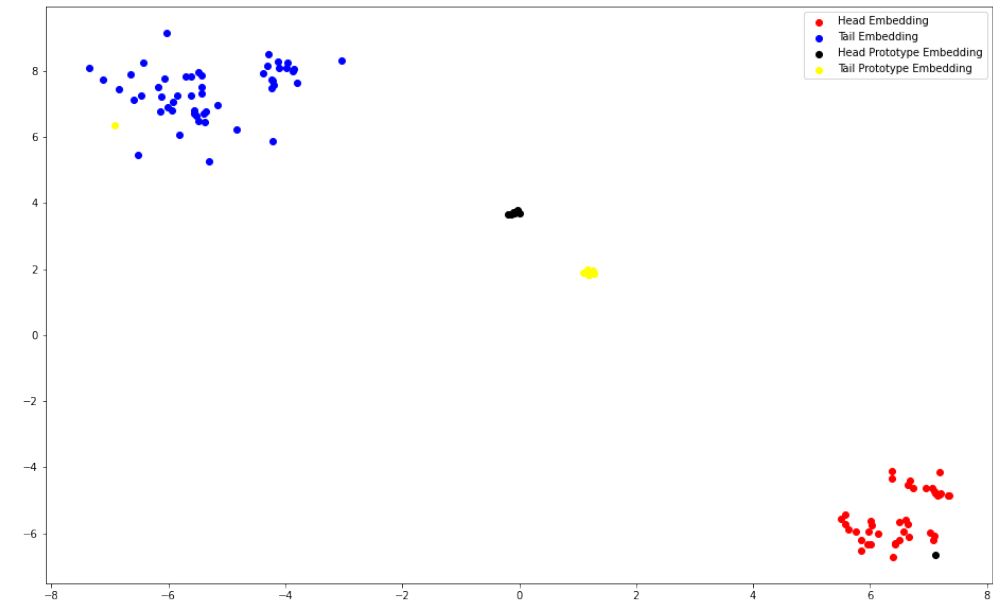
Figure 6. Visualization of prototype and entity embeddings in olympic_sports in